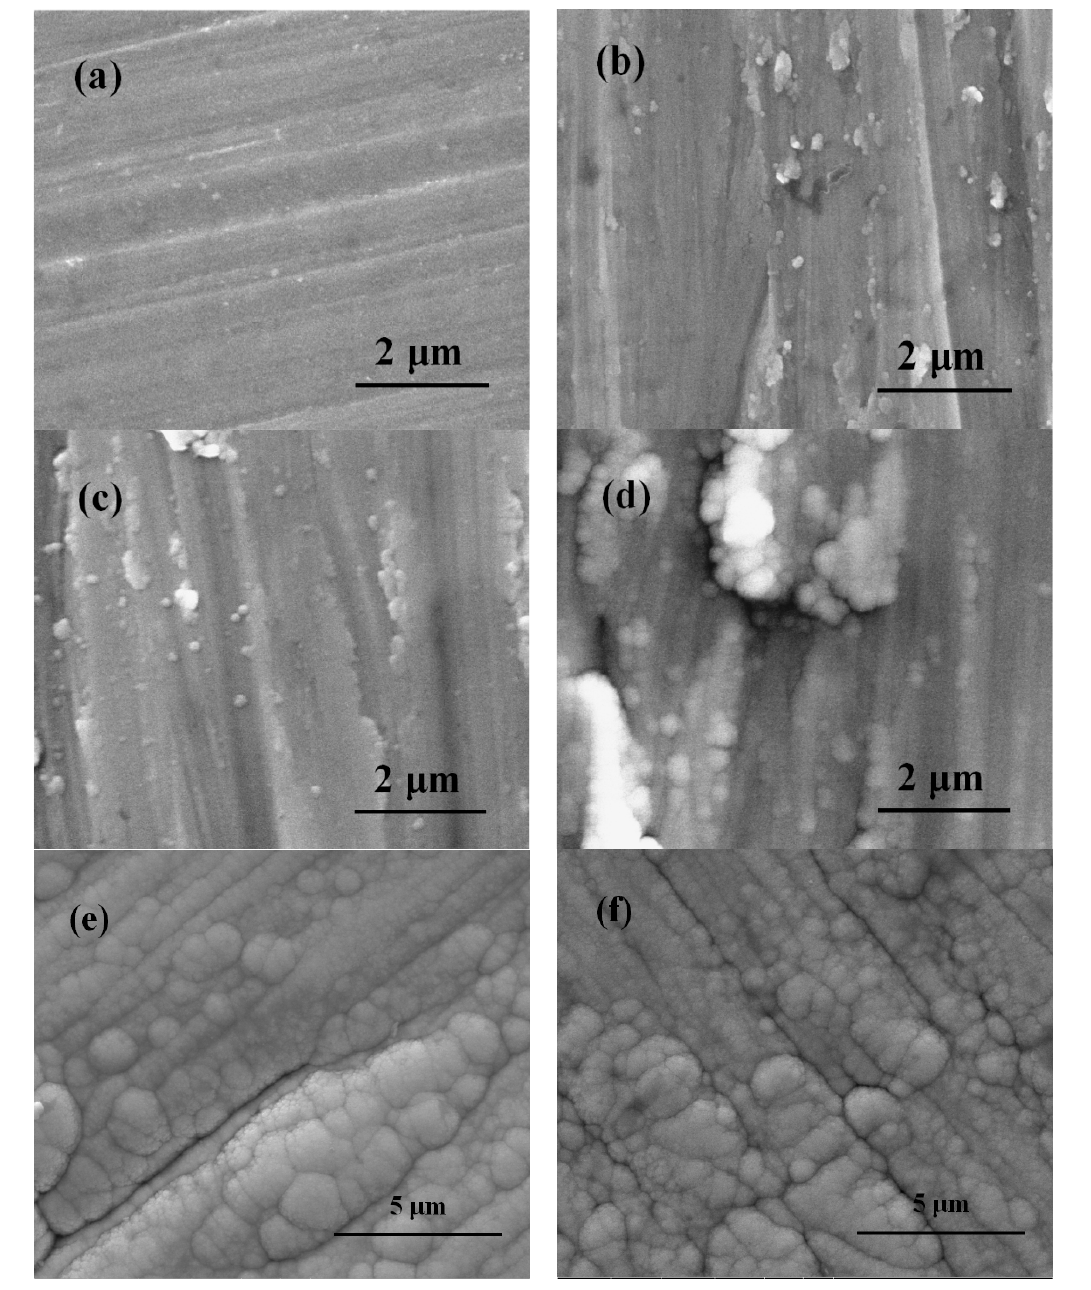
Figure 2. SEM images of the surface of uncoated and coated Ti6Al4V samples: (a) Ti6Al4V, (b) Ti, (c) TiO 2 , (d) Ta x O y -TiO 2 , (e) ZnO-Ta x O y , and (f) Ta x O y .